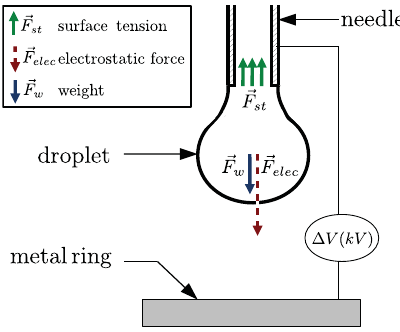
Fig. 4. Diagram of the forces applied to the water droplet before falling from the needle.